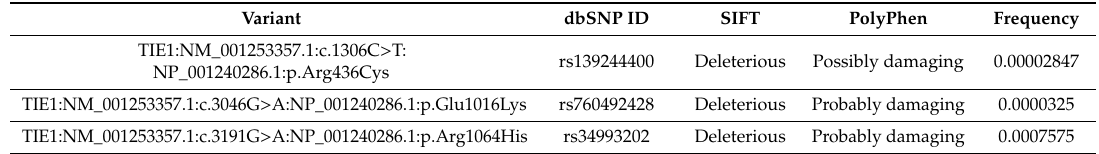
Figure 2. Modelled structure of the TIE1 gene in ( a ) ribbon ( b ) schematic and ( c ) CPK view. Cyan regions indicate beta sheets, white indicates loops and red indicates alpha helices. Table 3. Characterization of TIE1 variants.